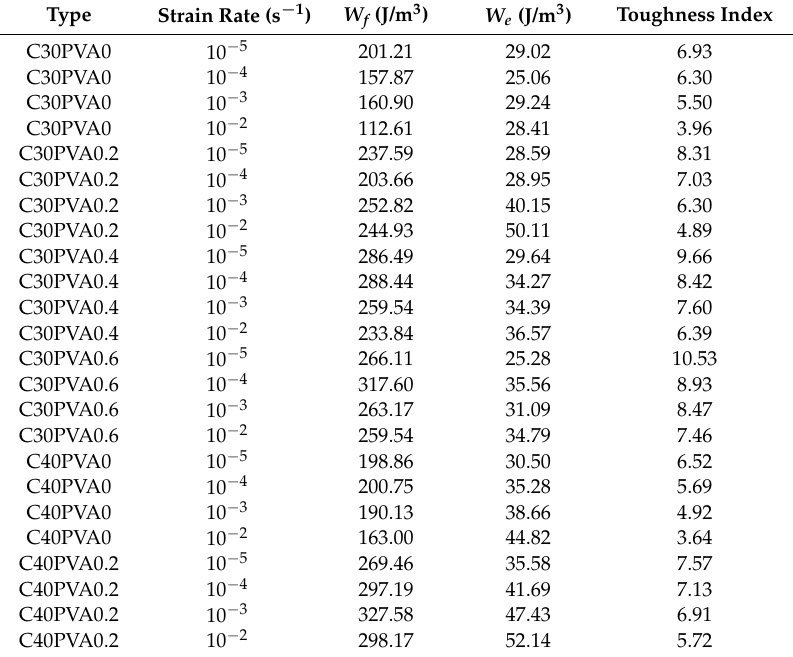
Table 4. Calculated results of toughness index for FRC at different strain rates.